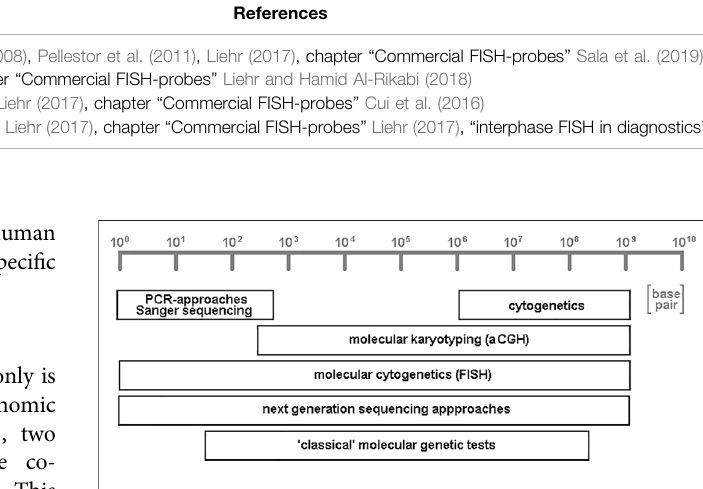
FIGURE 2 | Schematic depiction of resolutions achievable by variants of different cytogenomic approaches. Cytogenetics provides low resolution, but accesses the single cell level; PCR- and Sanger sequencing enable unique high resolutionofgenomes,while “ classical ” molecular genetictests(like Southern-blot and restriction fragment length polymorphism analyses) aCGH (array-comparative genomic hybridization) have low to intermediate resolution. Molecular cytogenetics, together with its variant molecular combing, and all variants of next-generation sequencing approaches are the onlytwogeneraltechniqueswhichcanaccessthewholegenome,fromlowto high